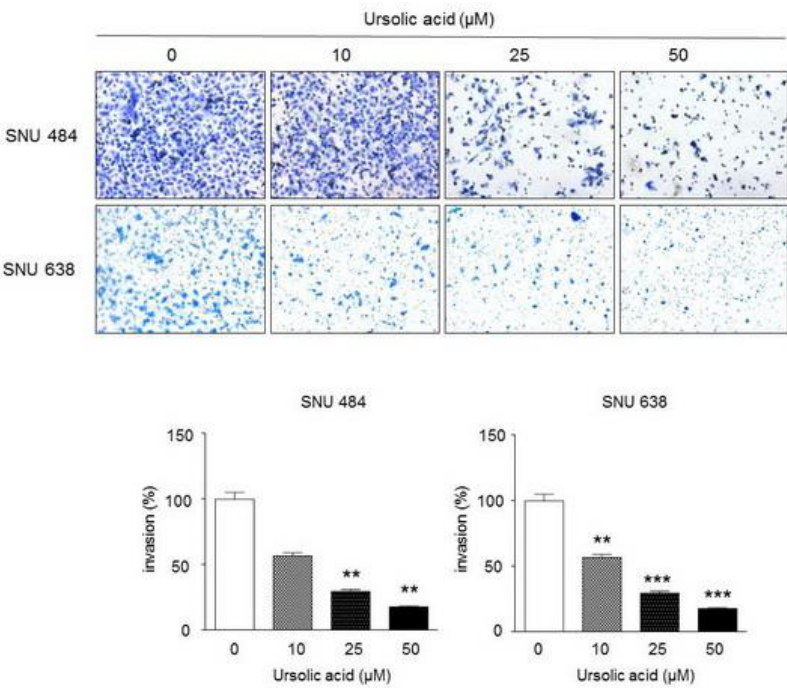
Figure 5. Effect of UA on the invasive rates of gastric cancer cells. SNU484 and SNU638 cells were treated with UA (0, 10, 25, and 50 μM), the invasion rates were detected by Materigel invasion assay. UA significantly inhibited the cell migration in a dose-dependent manner both at 24 h and 48 h. Data represent the mean ± SE of three independent experiments. ** p < 0.01 and *** p < 0.001 compared to the control.